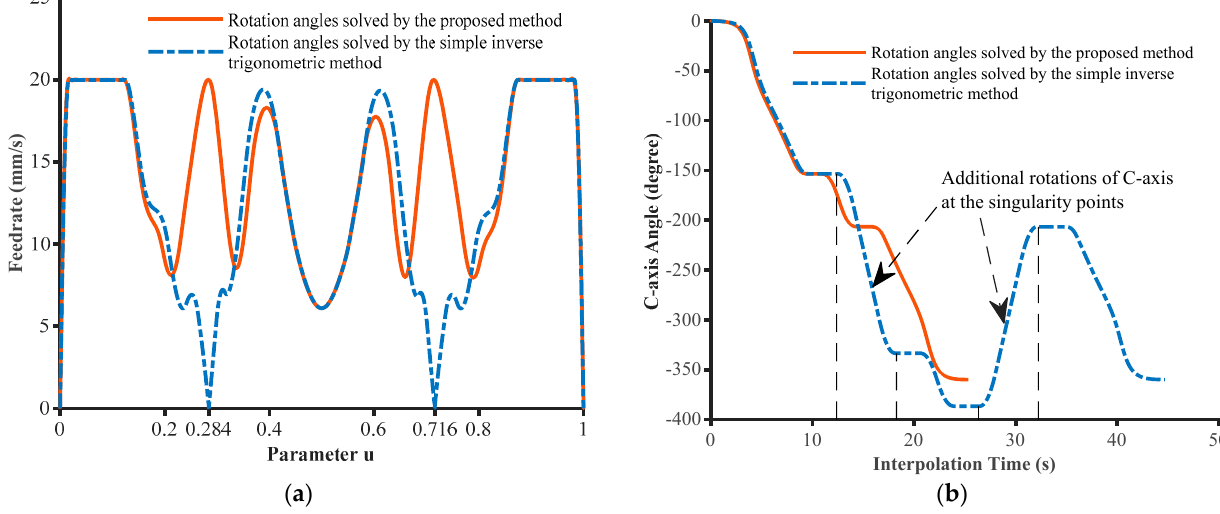
Figure 9. The optimization results of the cardioid curve feedrate. ( a ) The feedrate curves in the parameter field. ( b ) The C − axis angles with interpolation time.